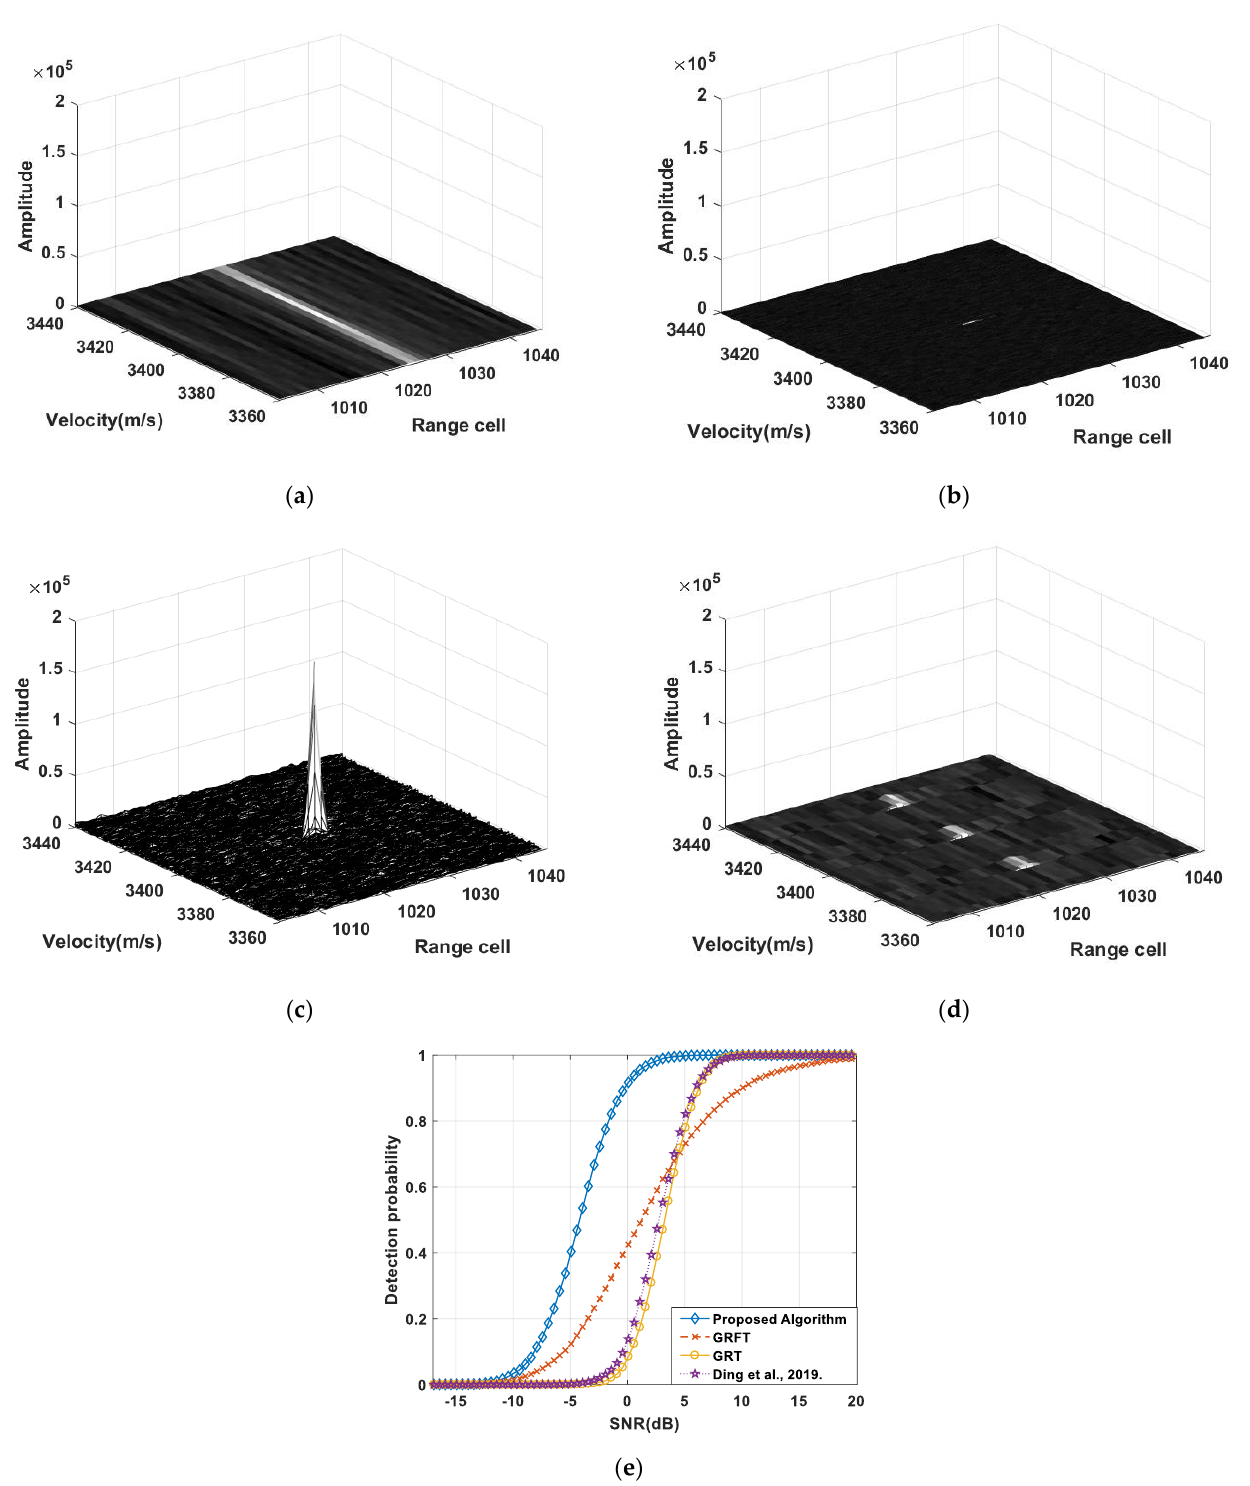
Figure 7. Simulation results in case 2. ( a ) Integration result via GRT; ( b ) Integration result via GRFT; ( c ) Integration result via the proposed method; ( d ) Integration result via MTD-GRT [47]; ( e ) Detection performance for four integration methods [47].